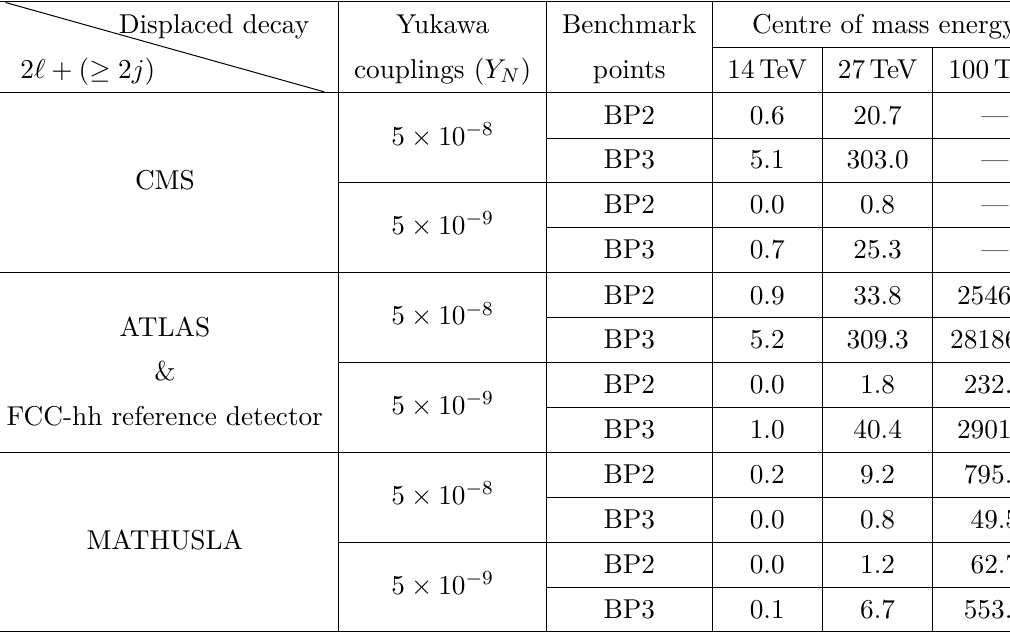
Table 14. Number of events in 2 ‘ + ( ≥ 2 j ) final state for the benchmark points, corresponds to the Yukawa couplings ( Y = ) 5 × 10 − 8 and 5 × 10 − 9 , with the center of mass energies of 14 TeV, N 27 TeV and 100 TeV at the integrated luminosities of 3 ab − 1 , 10 ab − 1 and 30 ab − 1 , respectively. The numbers are given separately for CMS, ATLAS, FCC-hh reference detector (for 100 TeV) and